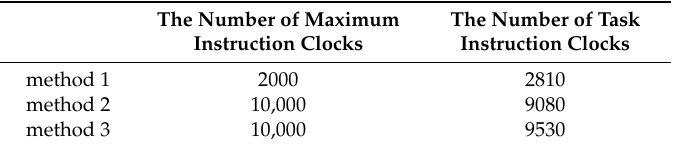
Table 3. The comparison of single-rate and multi-rate instruction clocks.